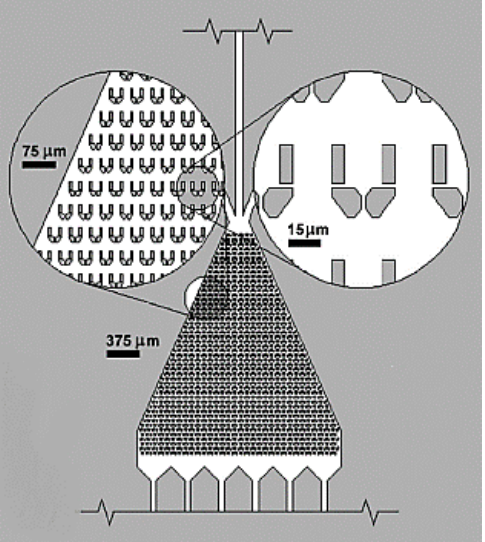
Figure 9. CAD schematic representation of the microfluidic device proposed by Wlodkowic et al. showing the traps in the triangular array. Reprinted with permission from [66]. Copyright (2009) American Chemical Society.